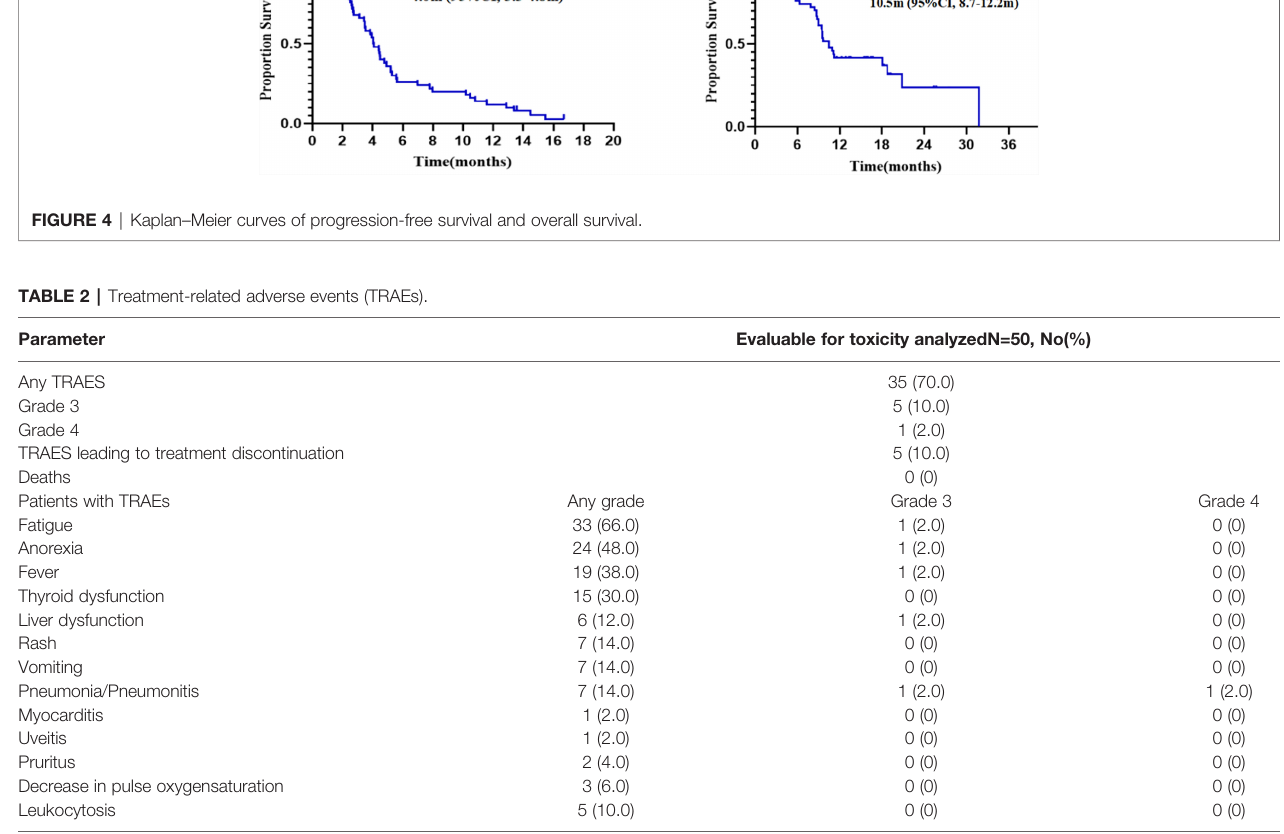
Figure 1 ). None of the lymphocyte subset percentage changes